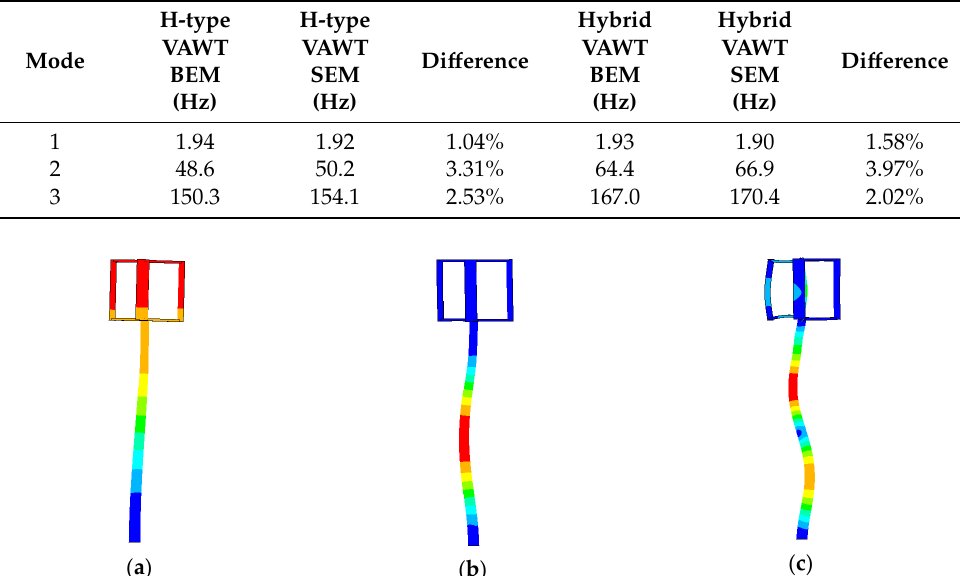
Figure 15. First three mode shapes of the H-type VAWT from its SEM that correspond to its X-Y planar motion: ( a ) the first mode shape with the natural frequency 1.92 Hz; ( b ) the second mode shape with the natural frequency 50.2 Hz; and ( c ) the third mode shape with the natural frequency 154.1 Hz.